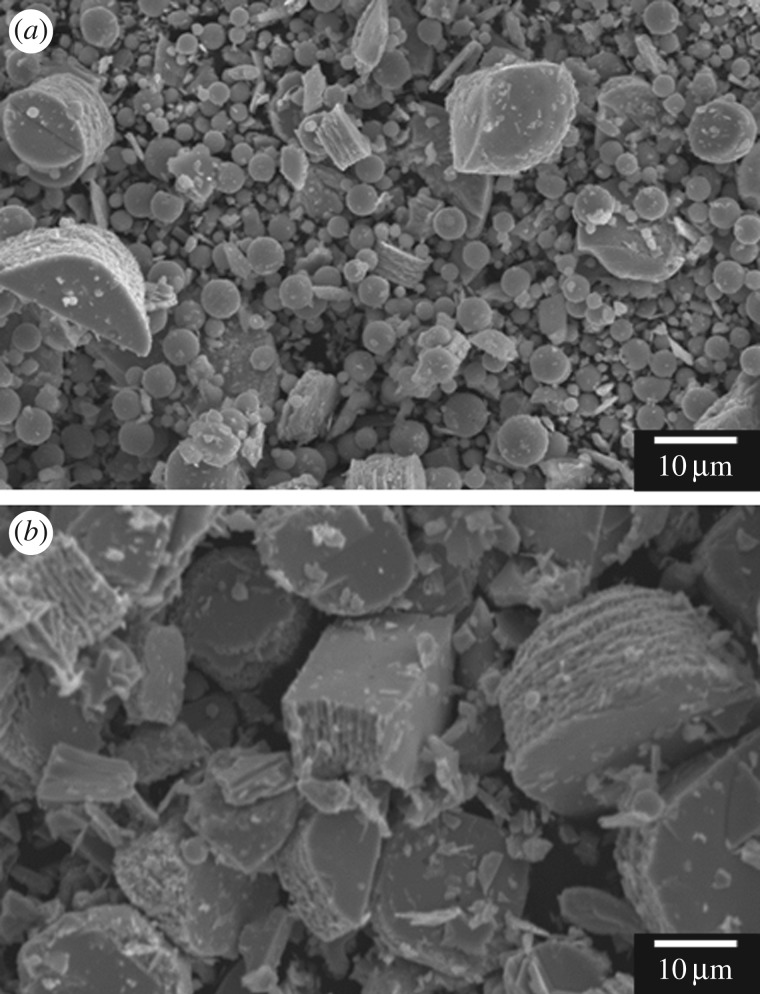
SEM images of WO3 precursors prepared by ageing for 4 (a) and 6 (b) days from (NH4)10W12O41 solutions with Cge = 2.0 g l−1 and HCl at pH 1.0.